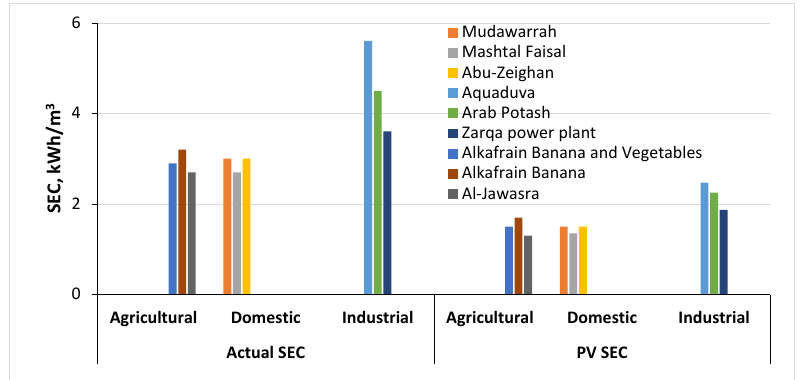
Figure 5. SEC in actual situation and when using PV solar energy by sector (kWh/m 3 ).